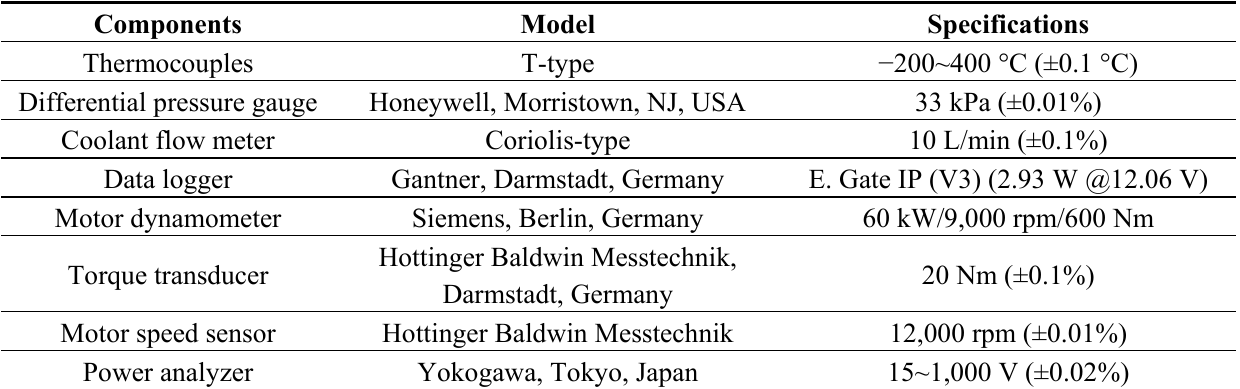
Table 3. Specifications of test